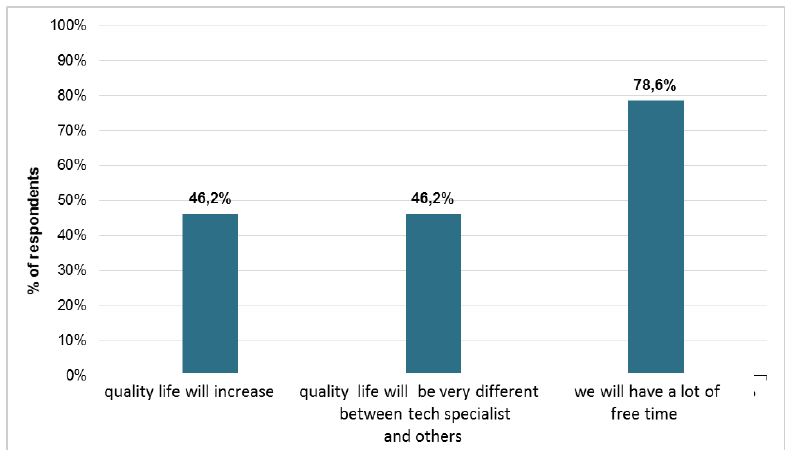
Figure 5. ICT Impact on Quality